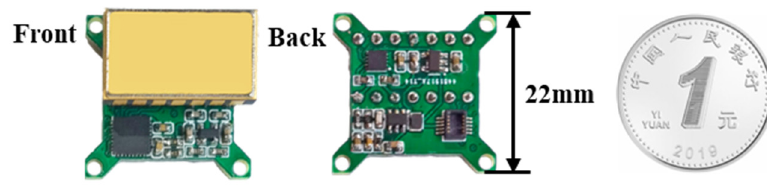
Figure 6. Physical drawing of the closed-loop accelerometer. Figure 5. Closed-loop functional diagram. Figure 5. Closed-loop functional diagram. Figure 5. Closed-loop functional diagram.